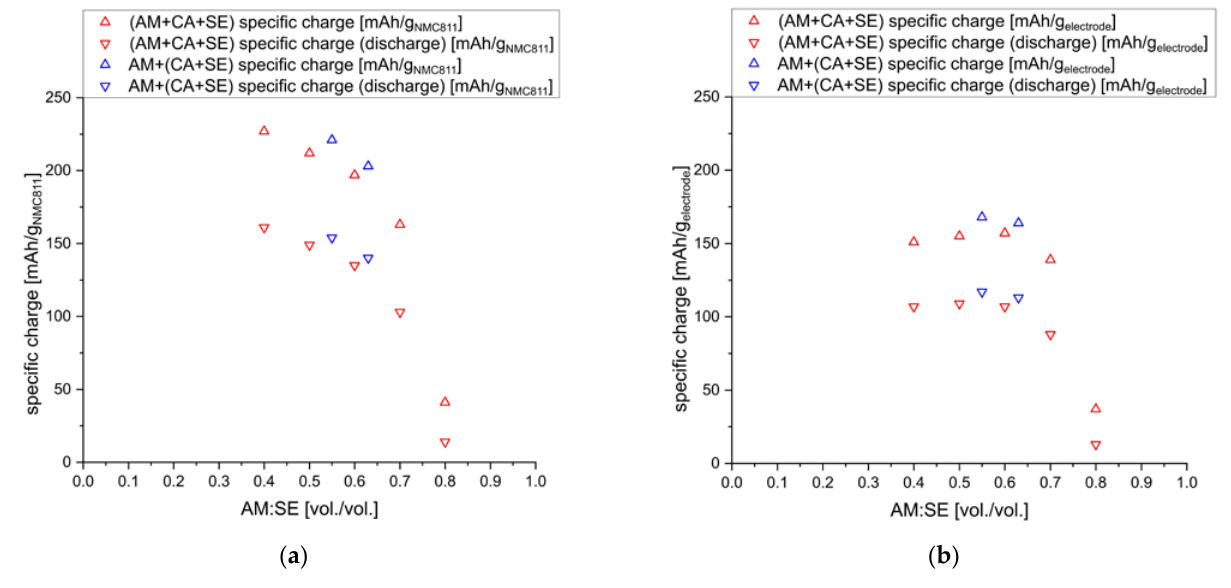
Figure 8. Specific charge values with respect to ( a ) the active material, ( b ) the whole electrode composite of cathodes using conventional (AM+CA+SE), and sequential mixing AM+(CA+SE) for different AM:SE ratios.